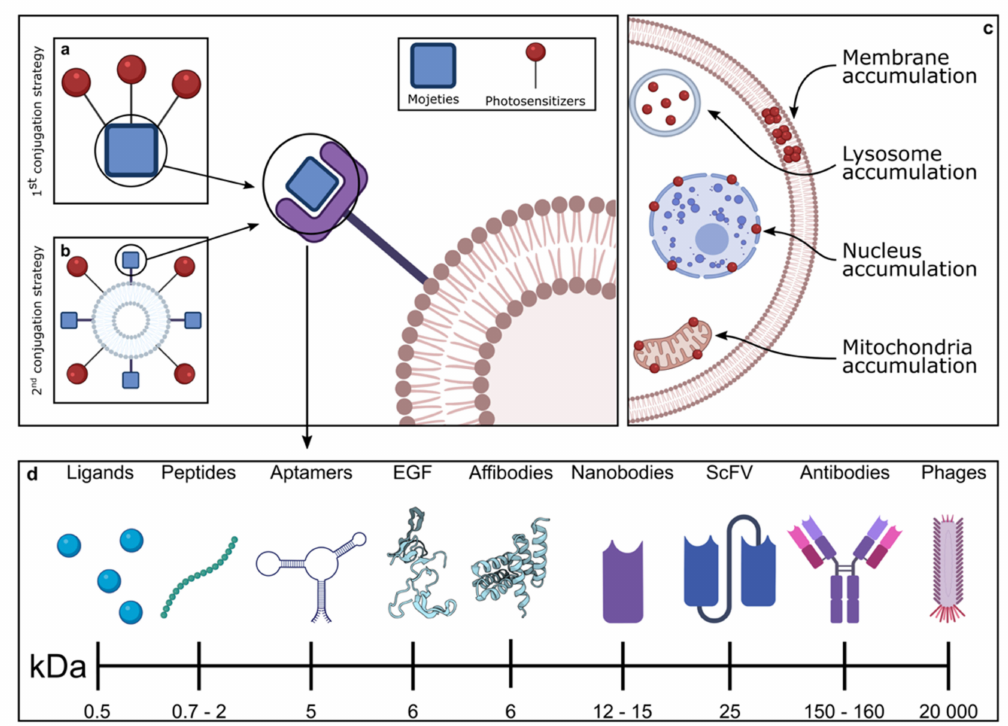
Figure 7. PDT conjugation strategies and targeting agents. ( a ) Direct conjugation of a PS to an EGFR-targeting agent. ( b ) Surface modification of a nanovector, incorporating a photosensitizer payload with EGFR-targeting agents. ( c ) Cellular localization of PSs after interaction between the targeting agent and EGFR receptor. ( d ) Different targeting agents used in EGFR-targeted PDT and their dimension in kDa. Created with